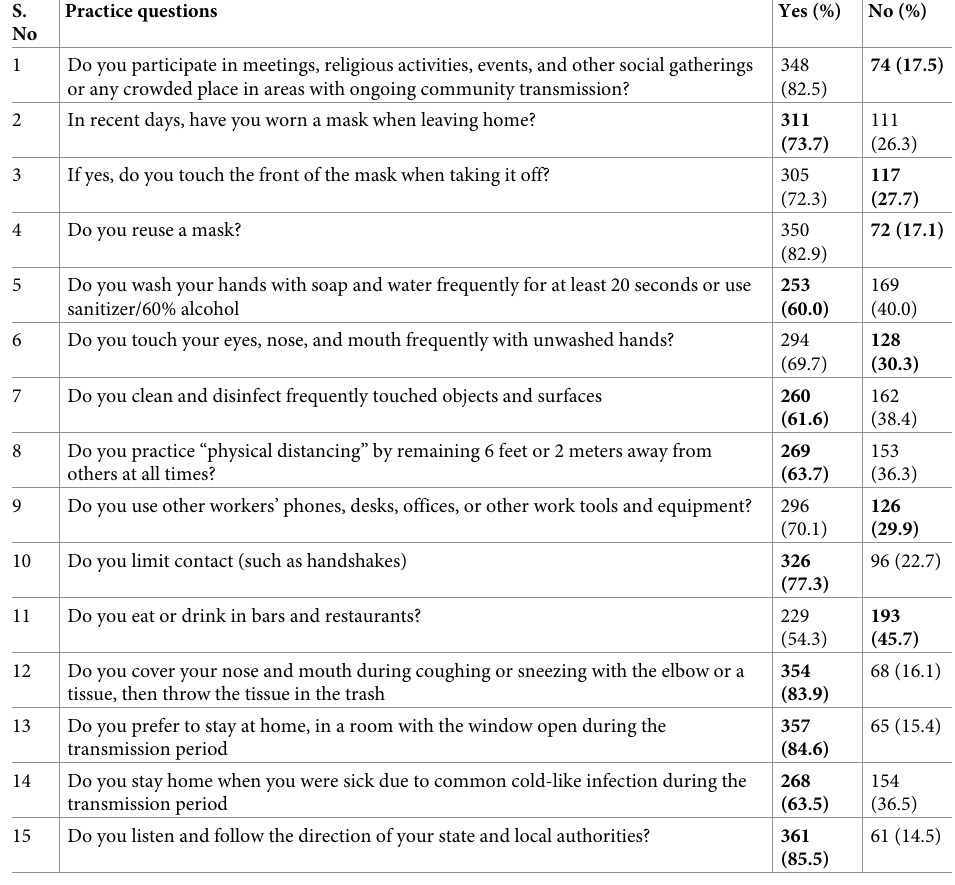
Table 3. Preventive practice toward COVID-19 among chronic disease patients at selected public hospitals of Sidama regional state, Ethiopia, 2020 (N = 422). S. Practice No